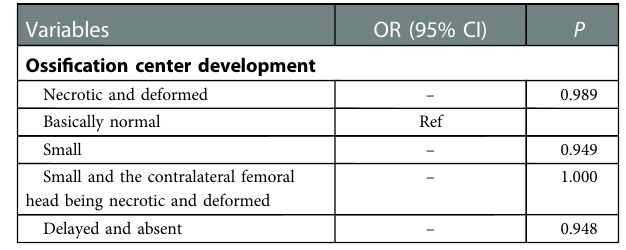
TABLE 2 Variables associated with postoperative ANFH.